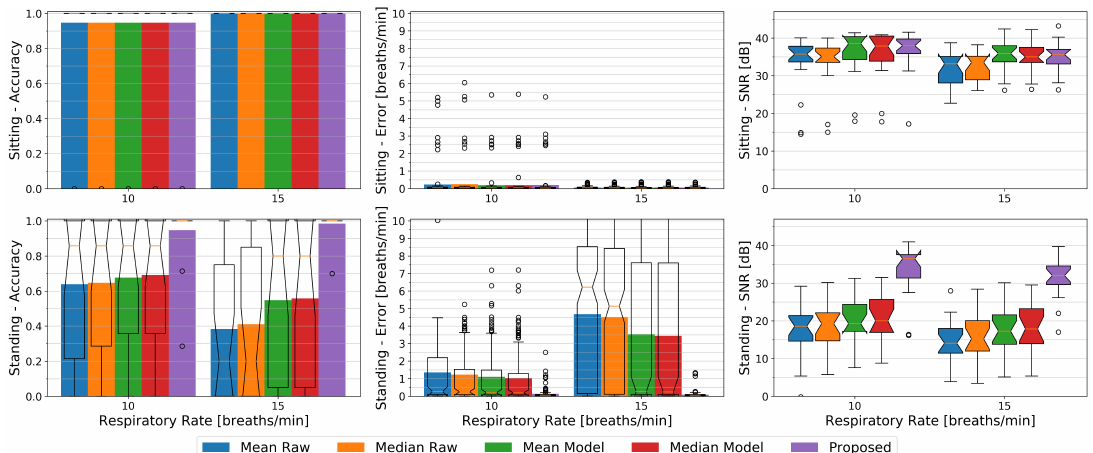
Figure 11. The respiration rate accuracies ( left ), errors ( middle ), and SNR ( right ) of the chest using a Fast Fourier Transform window with a length of 48 s, for the users performing three activities (sitting, standing upright, and drinking) for the following methods: Mean Raw, Median Raw, Mean Model, Median Model, and our proposed method. The colored bars show the averages, while overlay box plots show median (middle parts) and whiskers marking data within 1.5 IQR. Higher rates show a slightly better performance over all methods, especially when